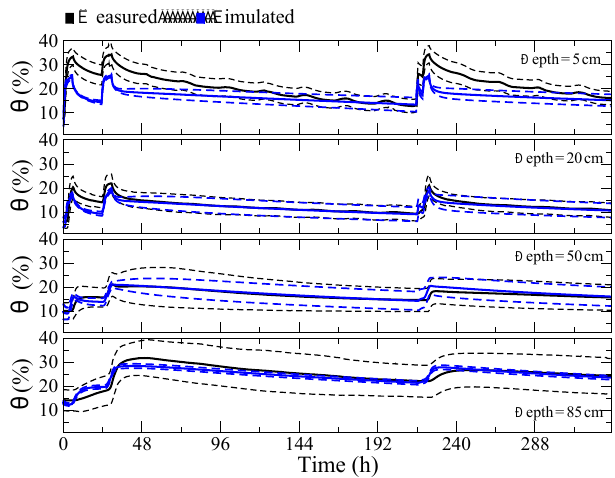
Figure 12. Averaged θ profiles at 5, 20, 50, and 85cm depths from the surface. In each graph the deviation from the mean (1 standard deviation above and below) is shown as dashed lines. The results are obtained for simulation l reported in Table